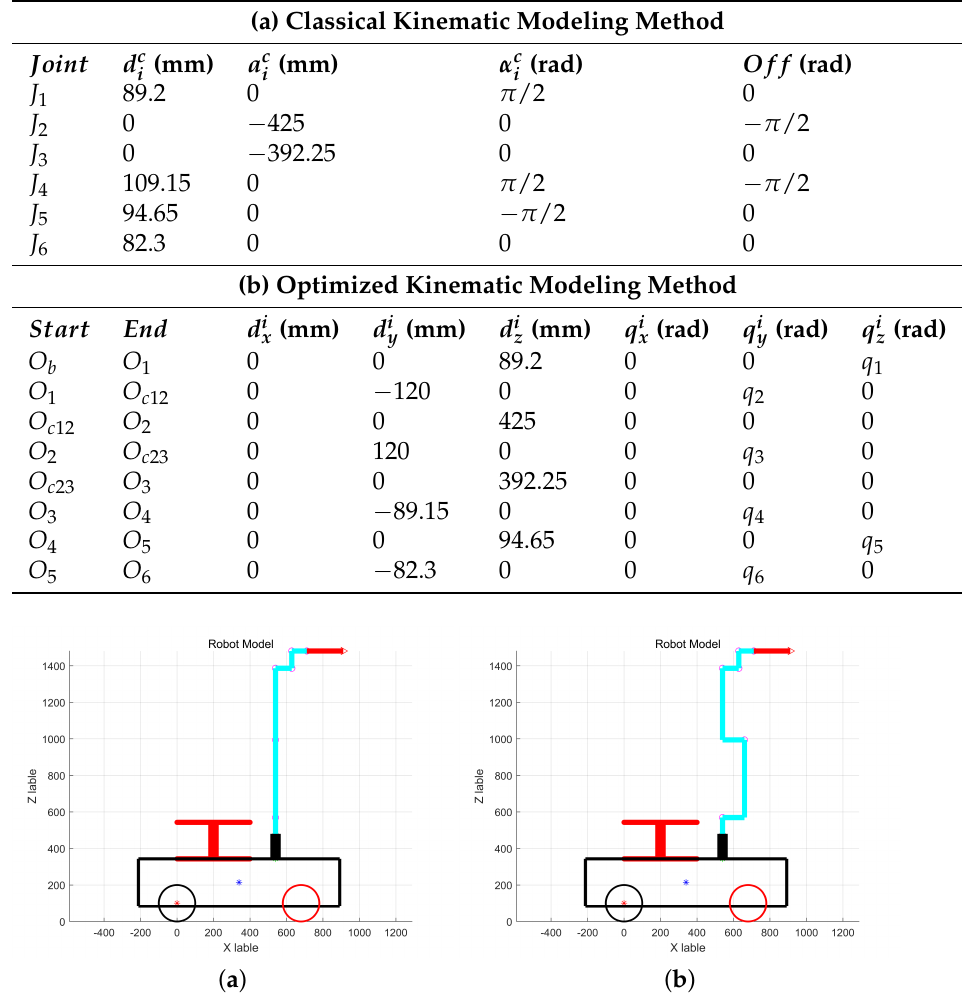
Figure 6. Kinematic modeling of the mobile manipulator robot with different methods (the ’*’ is the midpoint of these driving wheels, and the ’*’ is the gravity center of the mobile platform). ( a ) The classical kinematic modeling of the mobile manipulator robot; ( b ) The optimized kinematic modeling of the mobile manipulator